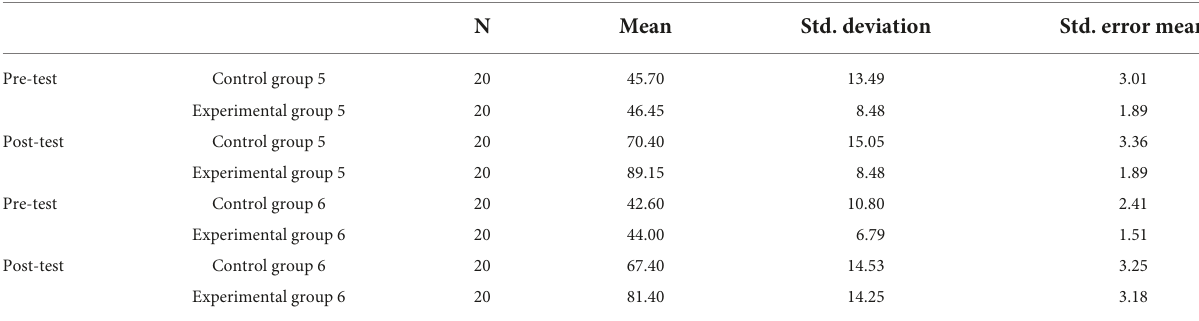
TABLE 1 Descriptive statistics of the pre-tests and the post-tests of the selected stages.